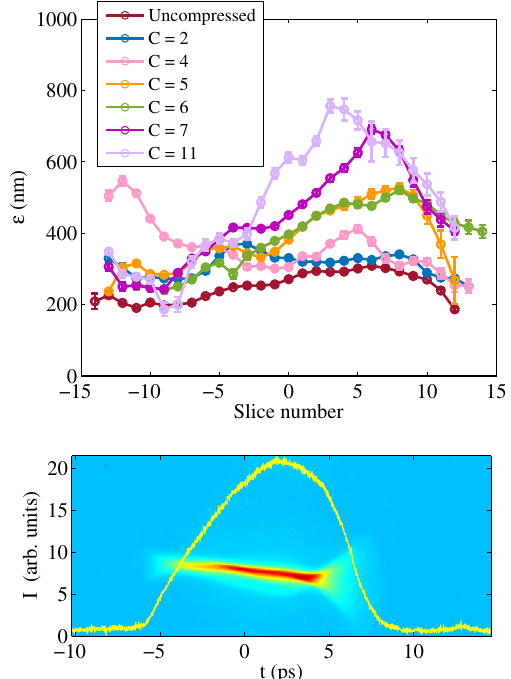
FIG. 2. Measured horizontal slice emittance along the bunch for different bunch compression factors C (top plot). The core slice is the one corresponding to the 0 slice number. The streaked beam is imaged on a screen and corresponding current profile (bottom plot). The beam energy is 200 MeV, the dipole bending angle 4.07°. The length of the single slice is scaled by the compression factor to ease the visual comparison of the different